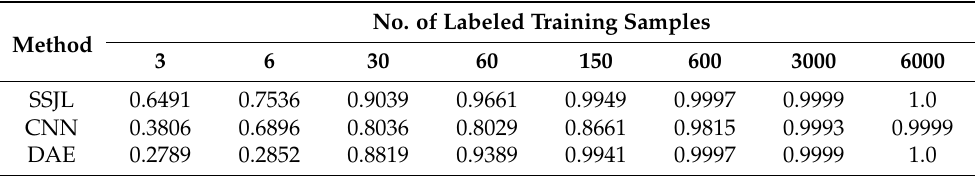
Table 8. Fault diagnosis accuracy of different methods on the MFPT dataset.